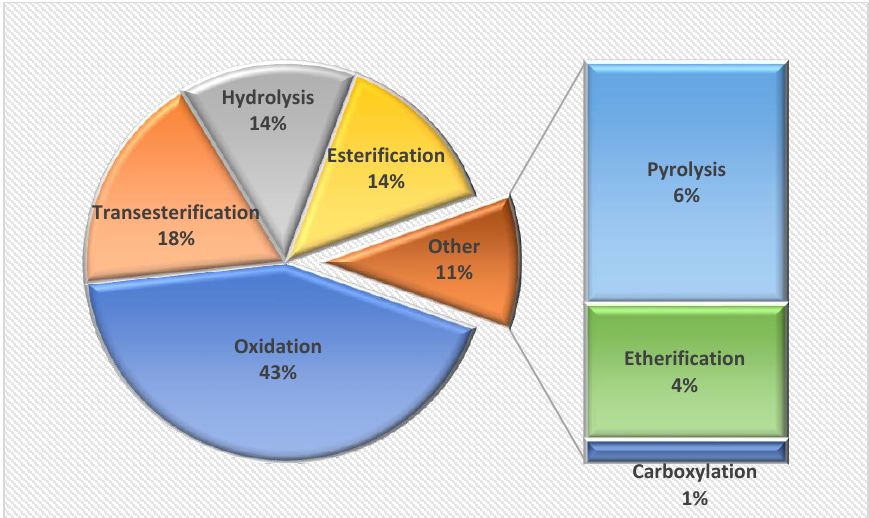
Figure 2. Processes for conversion of glycerol into added-value chemicals according to the number of articles published on the subject in the past eight years.